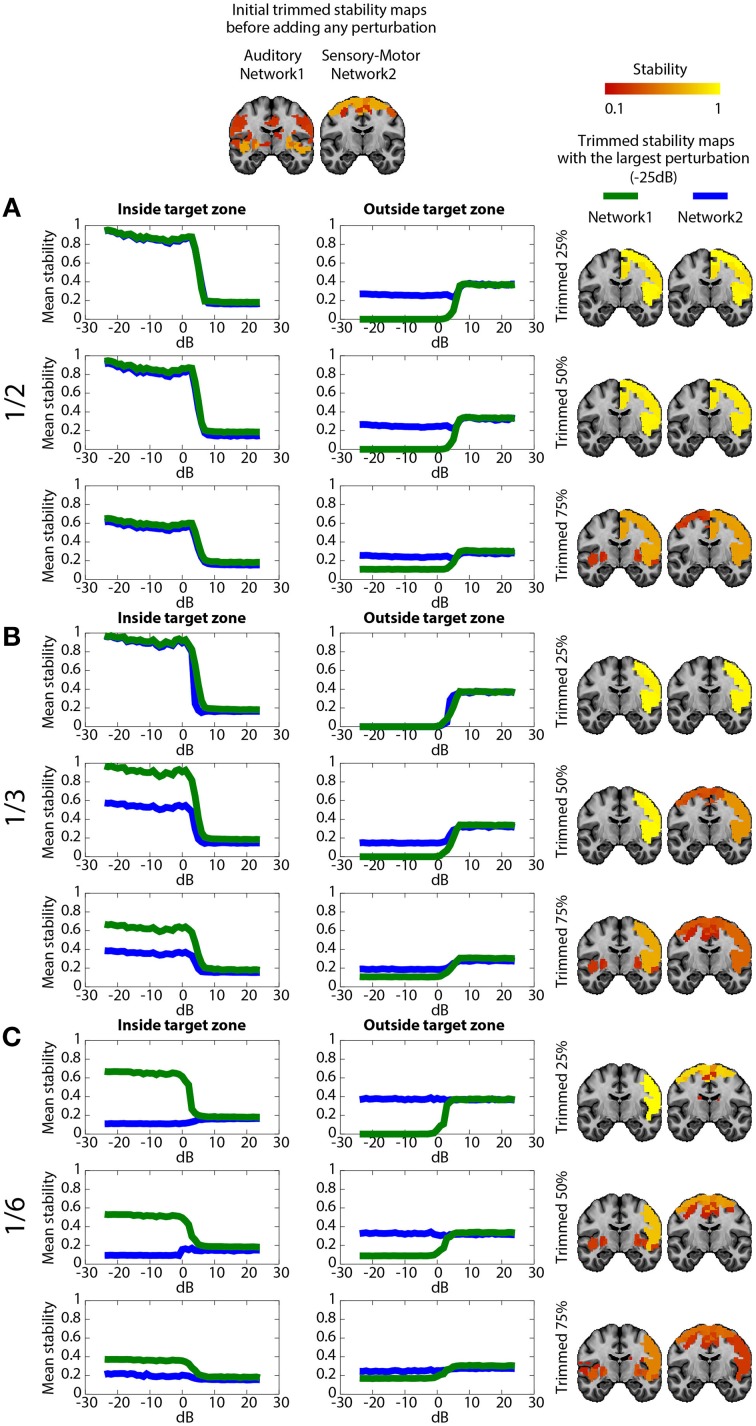
Evaluation of DANI using simulated data. The first line shows the initial trimmed stability maps Tn obtained for the Auditory network (network 1) and the Sensory-Motor network (network 2) before adding any perturbution. Graphs present the average stability inside In0 (left column) outside On0 (middle column) the perturbed area as a function of SNRdB values ranging from −25 dB to +25 dB, for both the Auditory (green) and the Sensory-Motor (blue) networks. The right column shows the resulting trimmed stability maps Tn obtained when adding the largest perturbation at SNRdB = −25dB. (A) perturbation zone involving 1/2 of both Auditory and Sensory-Motor networks, (B) perturbation zone involving 1/3rd of both Auditory and Sensory-Motor networks, (C) perturbation zone involving 1/6th of both Auditory and Sensory-Motor networks. In each case, results obtained when varying the core size parameter μ at 25, 50, and 75% are presented.